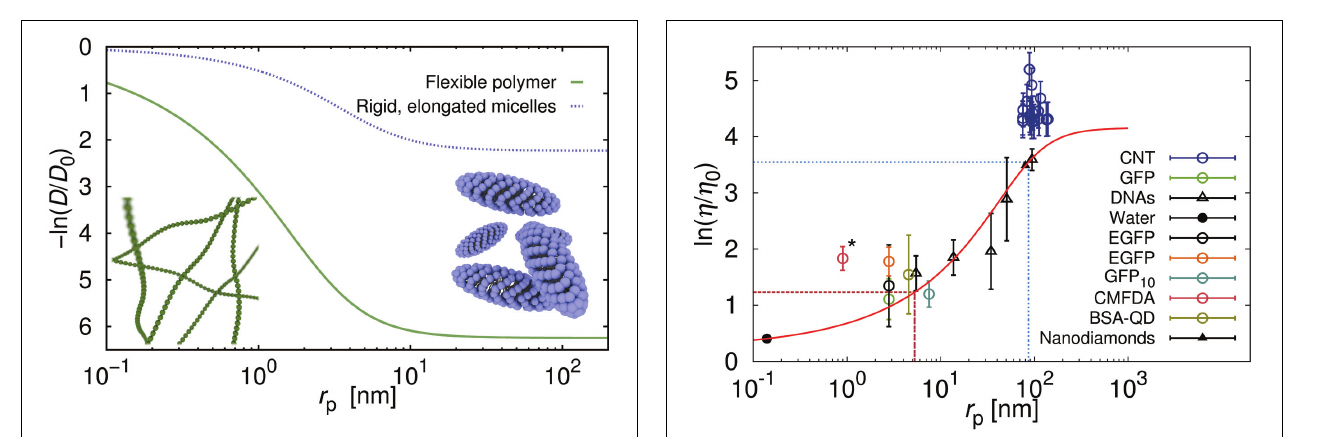
FIGURE 3 | Relative viscosity ( η/η 0 ) that is equivalent to the reciprocal of the diffusion coefficient ( D 0 / D ) for various probes diffusing in the cytoplasm of HeLa cells. Black points correspond to the data [149–152] discussed in Kalwarczyk et al. [14] and the red solid line represent the best fit (Equation 5) to those data with: ξ ≈ 5nm and R h ≈ 86nm marked as red dashed and blue dotted lines, respectively, [for details please see [14]]. Reproduced with permission from reference 14. Copyright 2011 American Chemical Society. Colored points represent data published recently for carbon nanotubes (CNT) [32], green fluorescent protein (GFP) [33], enhanced green fluorescent protein (EGFP) [34], oligomer of ten GFP proteins (GFP 10 ) [29], fluorescent dye – 5-chloromethylfluorescein diacetate (CMFDA) [29], and quantum dots stabilized with bovine serum albumin protein (BSA-QD) [31]. The carbon nanotubes, having huge aspect ratio, during the motion experience the hydrodynamic friction resulting not